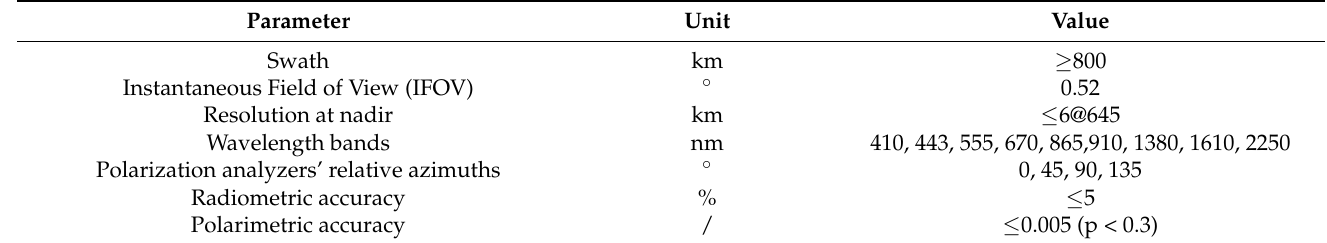
Figure 2. Schematic diagram of the optical path of the PSAC. It adopts a simultaneous polarization measurement scheme based on a combination of split-aperture and split-amplitude components and acquires 9 bands and 4 polarization analyzers’ relative azimuths (for a total of 36 channels) to obtain spectral intensity information simultaneously in the field-of-view range of − 32.5 ◦ ~ + 32.5 ◦ for cross-track scanning. Table 1. Main specifications of the PSAC.